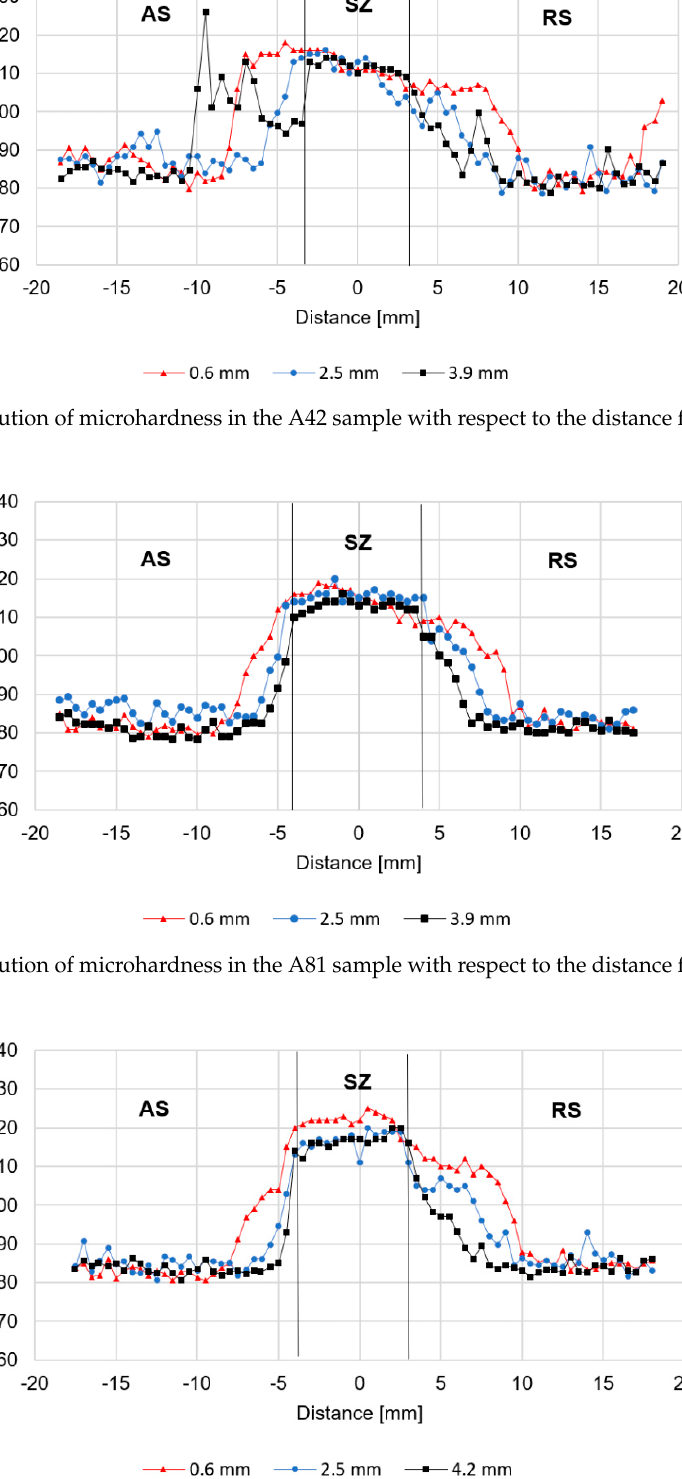
Figure 12. Distribution of microhardness in the A82 sample with respect to the distance from the top of the joint.